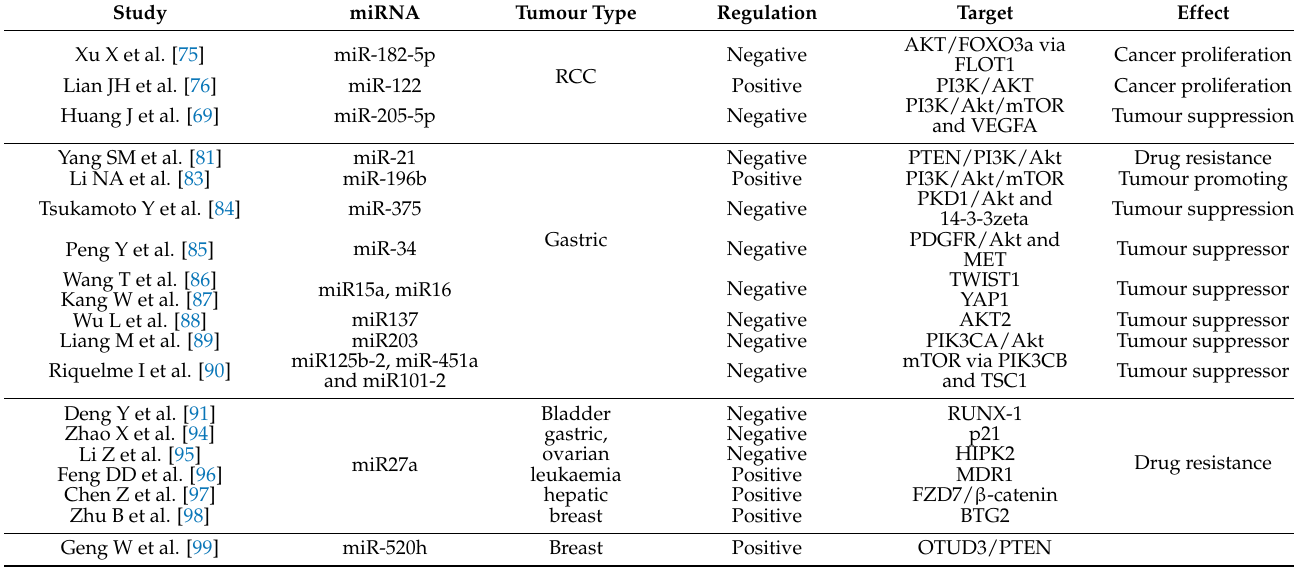
Table 1. The regulation of miRNAs on the PI3K/Akt pathway throughout different protein